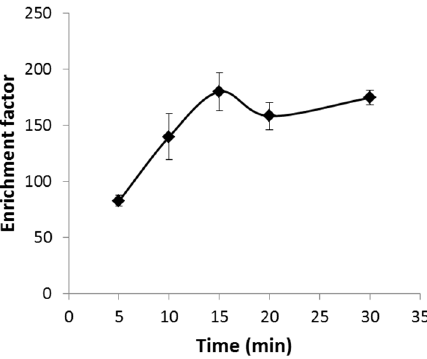
Figure 5. Effect of time of extraction on the enrichment factor. Sample pH = 5.5, DEHPA 0.9 M, 1.9 M stirring rate 500 rpm, and electric potential 25 HNO 3 1.9 M stirring rate 500 rpm, and electric potential 25 V.